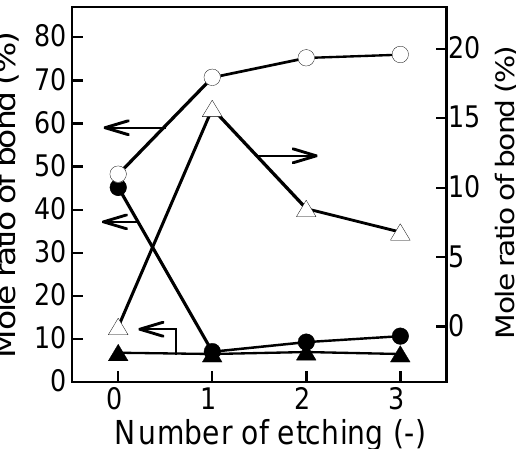
Figure 9. Atomic ratios of bonds on surfaces of SiO 2 /ZrO 2 -coated substrates as a function of the number of Ar + etching steps. (●) Zr -O, ( △ ) Si-O-Zr, ( 〇 ) Si-O, and ( ▲ ) Si-OH. The as-prepared sam- ple was the same as that in Figure 5(b1).